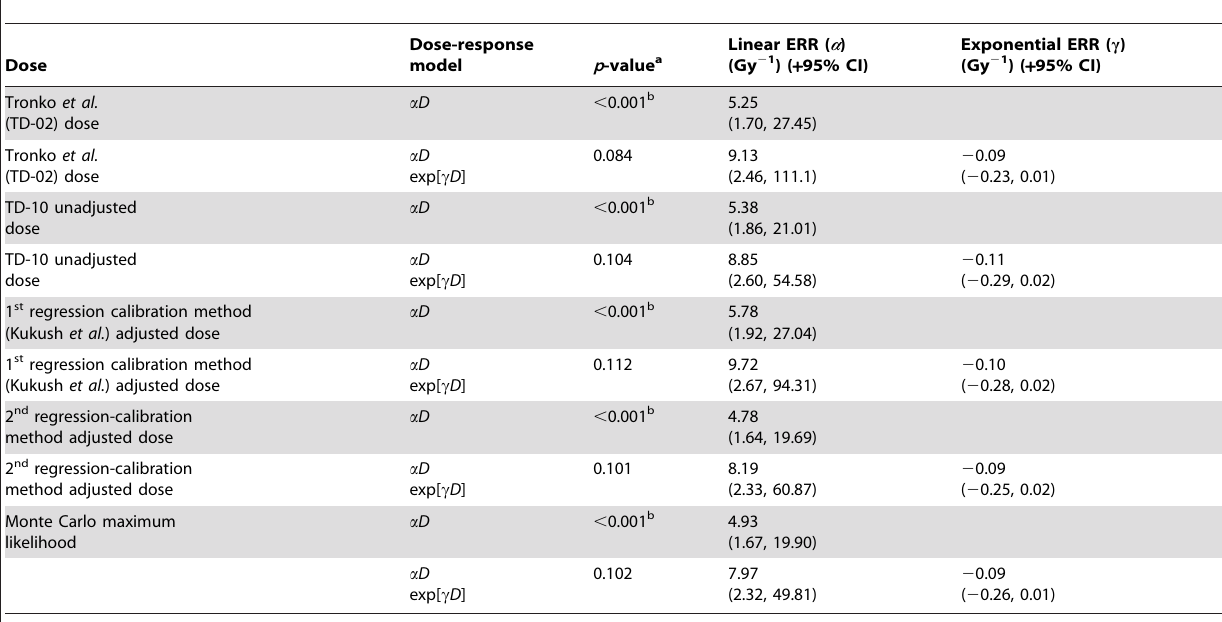
Table 2. Analysis of curvature in fits of EOR model (2) with or without adjustment for dose errors using regression calibration, for TD-10 doses.